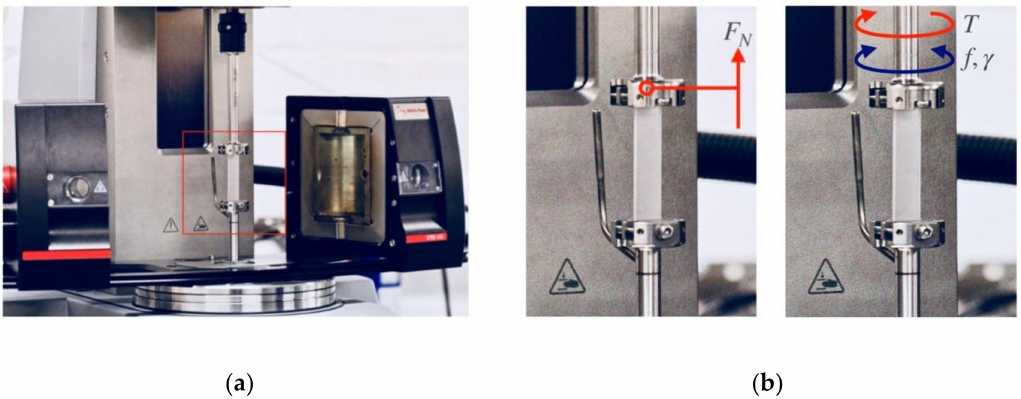
Figure 2. Experimental setups based on the Anton Paar MCR702 rotational rheometer SRF 12 fixture for: ( a ) creep measurements (note: creep sample not represented to scale) and ( b ) dynamic mechanical thermal analysis (DMTA). Both ( a , b ) configurations are depicted in open convection oven